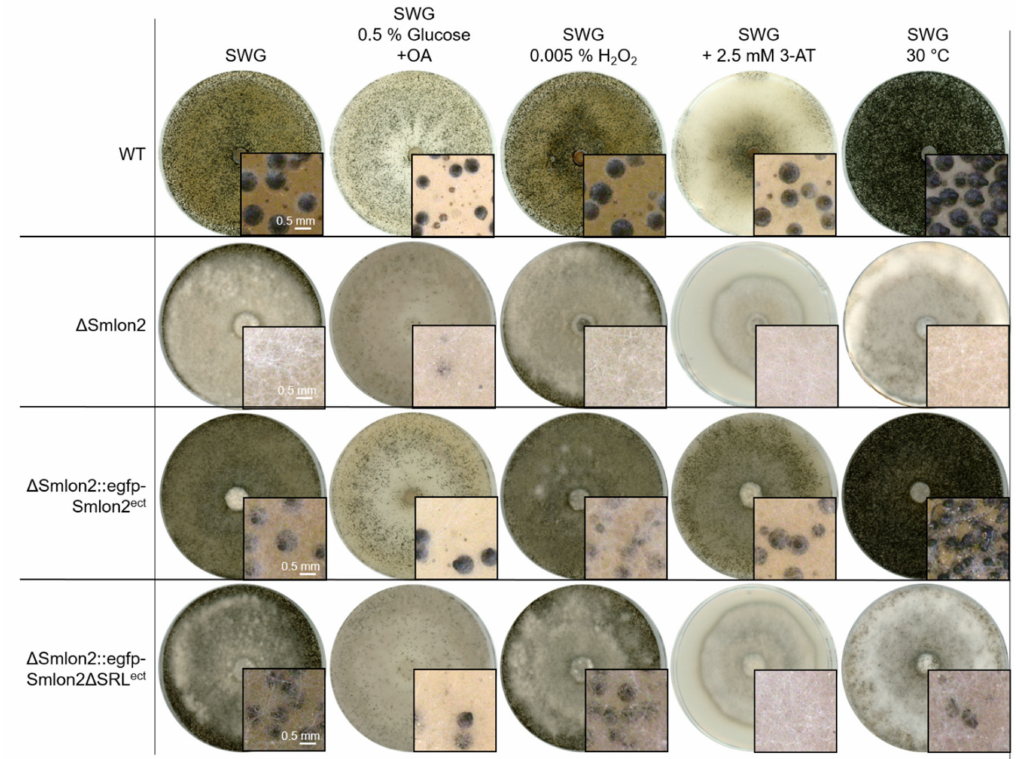
Figure 5. Sexual development of S. macrospora WT, ∆ Smlon2 and the complementation strains expressing variants of Smlon2 under different stress conditions. WT, ∆ Smlon2 and complementation strains expressing the S. macrospora ( ∆ Smlon2::egfp- Smlon2 ect ) and the mutated version of Smlon2 ( ∆ Smlon2::egfp-Smlon2 ∆ SRL ect ), respectively, were grown under normal conditions on fructification medium (SWG) at 27 ◦ C. For the induction of β -oxidation in microbodies the amount of glucose in the SWG medium was reduced to 0.5% and 0.15% oleic acid (OA) was added. Oxidative stress was induced by the addition of 0.005% H 2 O 2 and amino-acid starvation was induced by adding 3-amino-1,2,4-triazole (3-AT, 2.5 mM) to SWG medium. Temperature stress was performed by cultivation of the strains at 30 ◦ C. Pictures of agar plates were taken after 8 d. Magnifications are shown in the image details. Scale bars are